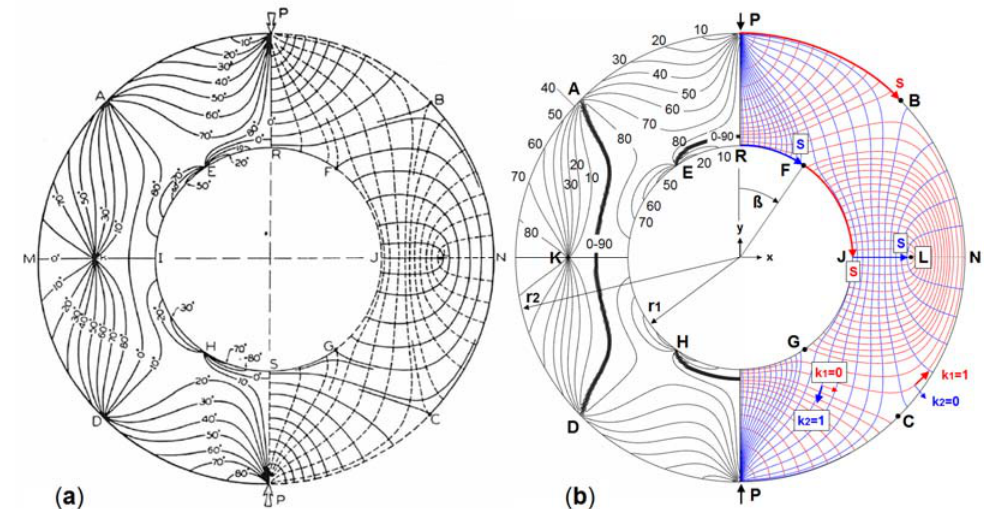
Figure 8. Circular ring under diametrically opposed single forces, r 2 /r 1 = 2: ( a ) Photoelastic isoclines (left) and trajectories (right) [15]; ( b ) Verification with ABAQUS, isoclines (left), σ 1 trajectories and σ 2 trajectories (right).